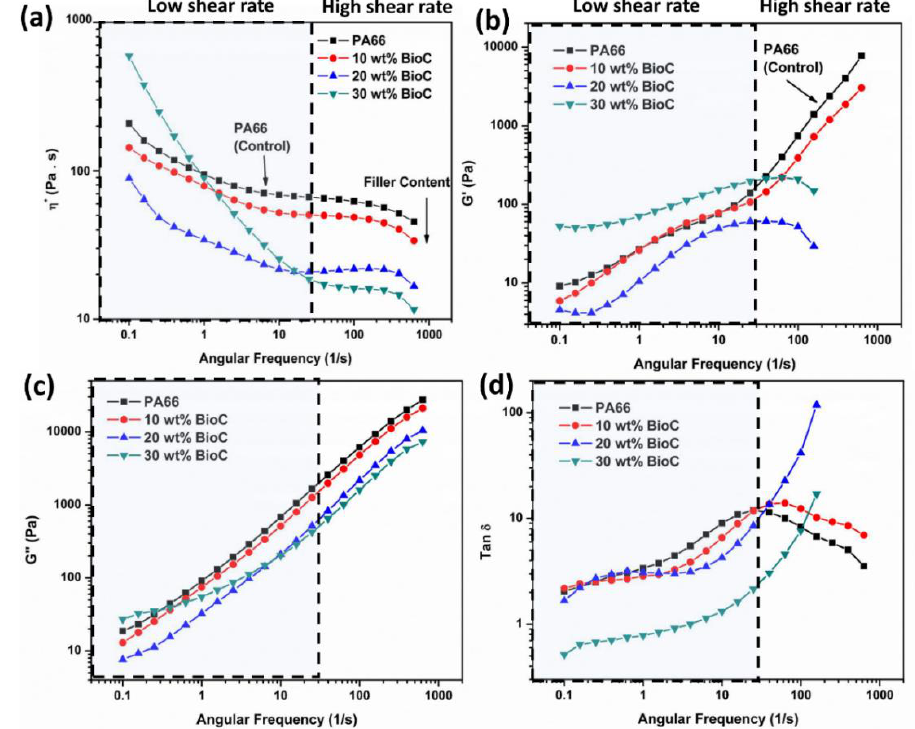
ff erent contents of 900 ◦ C pyrolytic temperature of Figure 10. Rheological behavior of PA66 with different contents of 900 °C pyrolytic temperature of Figure 10. Rheological behavior of PA66 with di BioC. ( a ) Complex viscosity; η *, ( b ) storage modulus; G (cid:48) , ( c ) loss modulus; G (cid:48)(cid:48) , and ( d ) Tan